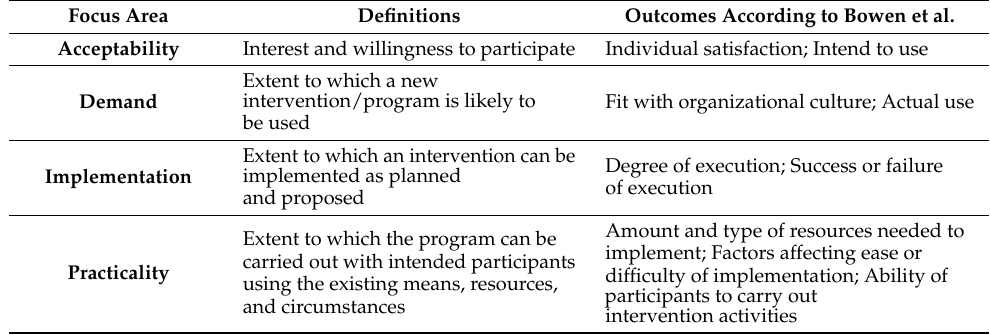
Table 1. Selected areas of focus for feasibility studies and possible outcomes according to Bowen et al. Focus Area Definitions Outcomes According to Bowen et